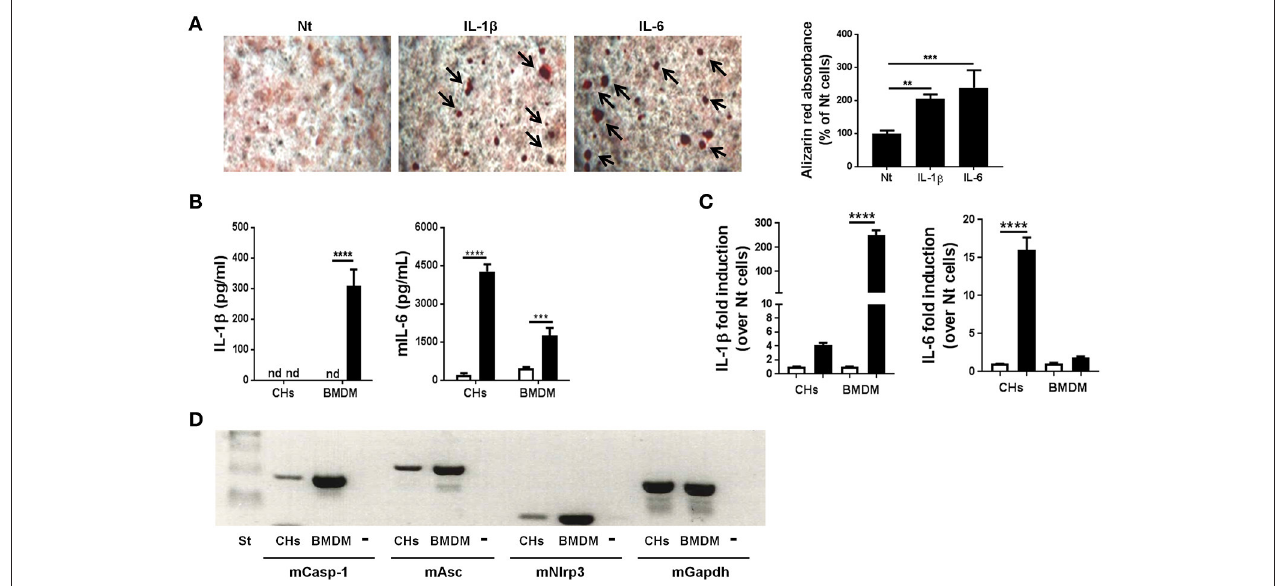
FIGURE 4 | Murine primary chondrocytes express the components of the NLRP3 inflammasome but do not produce IL-1 β upon HA crystal stimulation. (A) Alizarin red staining and quantification in murine chondrocytes culture, stimulated or not with 5 ng/ml IL-1 β or with 10 ng/ml IL-6 for 7 days in BGJb medium. Values represent means ± SD of triplicates from one representative experiment out of three. (B) IL-1 β and IL-6 secretion by primed CHs or by BMDM, stimulated (black bars) or not (white bars) with HA crystals for 6 h. Values represent means ± SD of triplicates from one representative experiment out of three. (C) qRT-PCR analysis of the indicated genes in CHs and BMDM stimulated (black bars) or not (white bars) with 100 µ g/ml PAM3Cys for 2 h. Results are expressed as the fold increase of gene expression in PAM3Cys treated over not treated (Nt) cells, using the mean ± SD of triplicate independent RNA samples. (D) Gel electrophoresis for the analysis of Caspase-1, Asc and Nlrp3 expression in primary murine chondrocytes (CHs) and primary bone marrow derived macrophages (BMDM). Minus (-) is the negative control (water). All experiments were performed using pools of primary cells from at least 3 different mice. ** p < 0.01, *** p < 0.001, **** p <